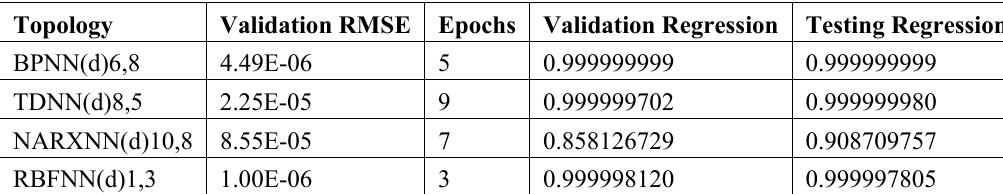
Table 5. Best topologies performance summary.